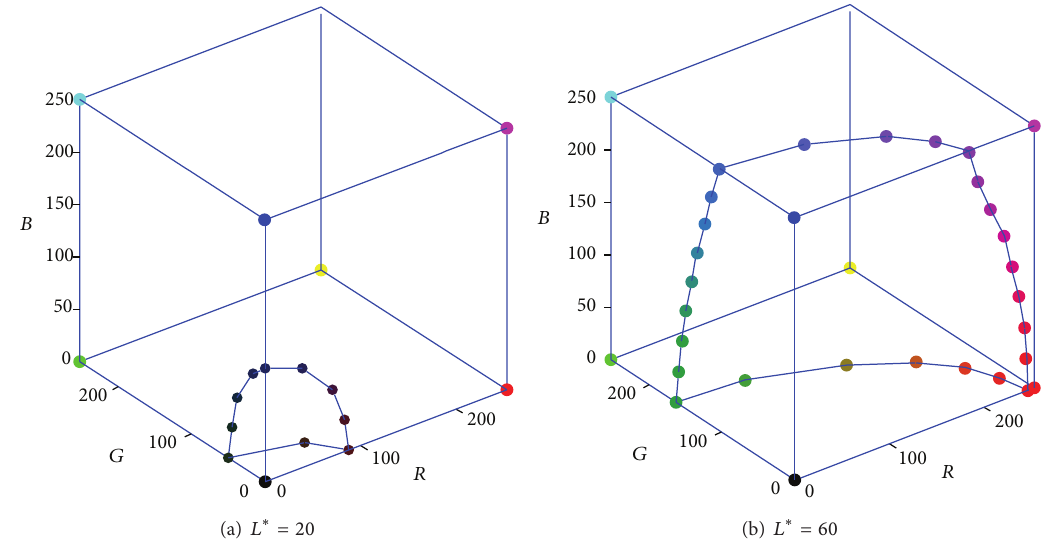
Figure 4: The scattered constant-lightness gamut boundary on RGB cube’s faces.